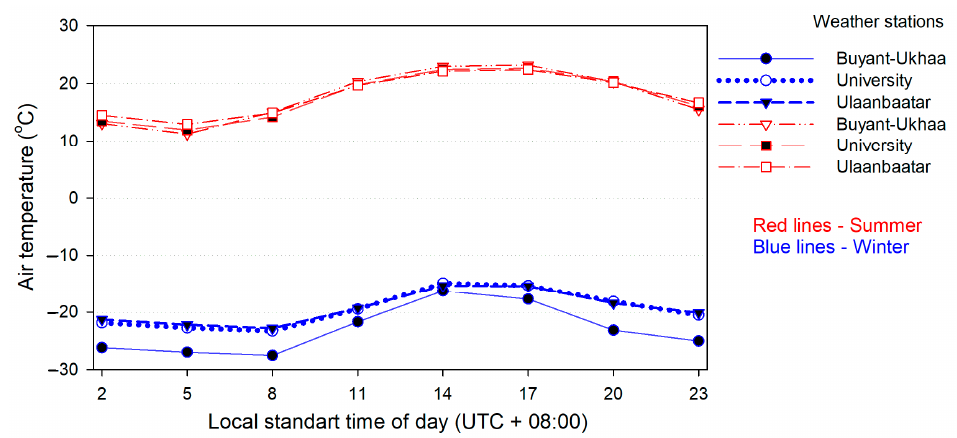
Figure 6. Diurnal variations in average air temperature in winter and summer.